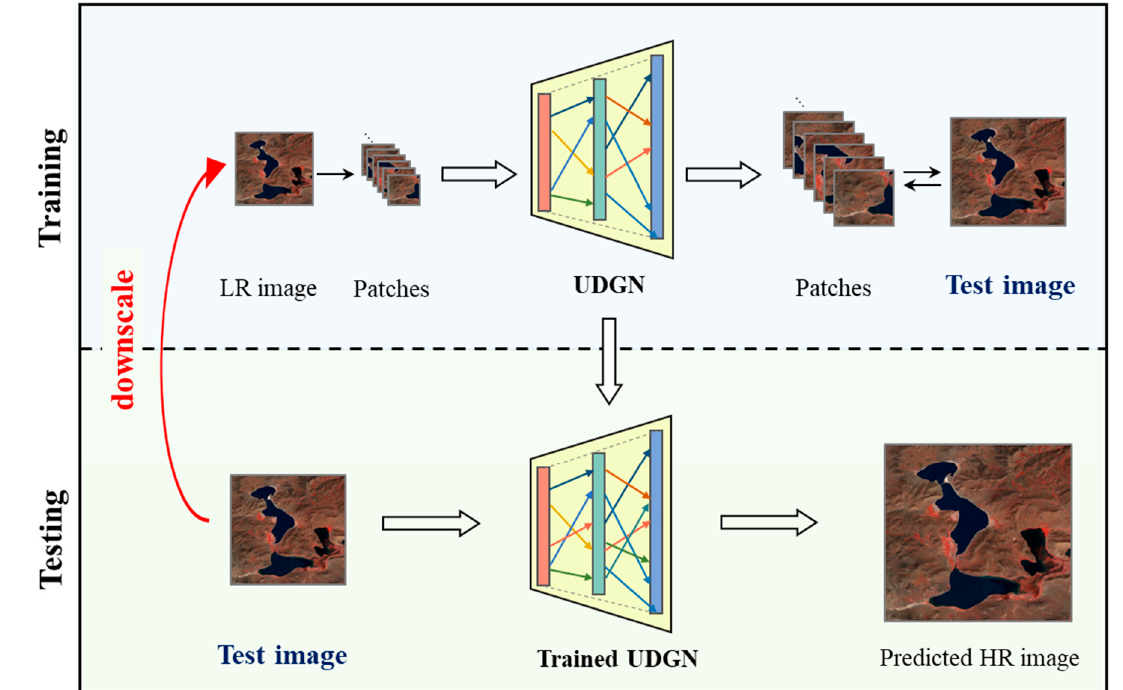
Figure 4. Unsupervised learning mechanism. An image-specific UDGN model is trained on examples extracted internally, from the test image itself. The test image is firstly down-sampled to lower resolutions, and then the UDGN is trained to recover the test image from its low-resolution (LR) versions. Finally, the resulting self-supervised network is applied to the test image to produce high-resolution (HR) images.